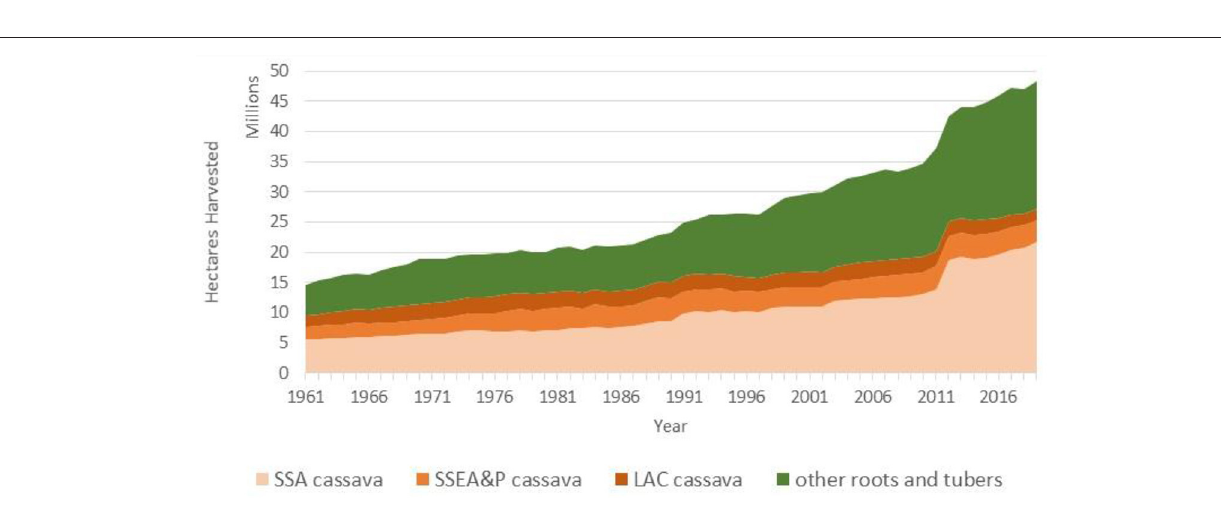
world’s major exporters (Cambodia, Myanmar, India,